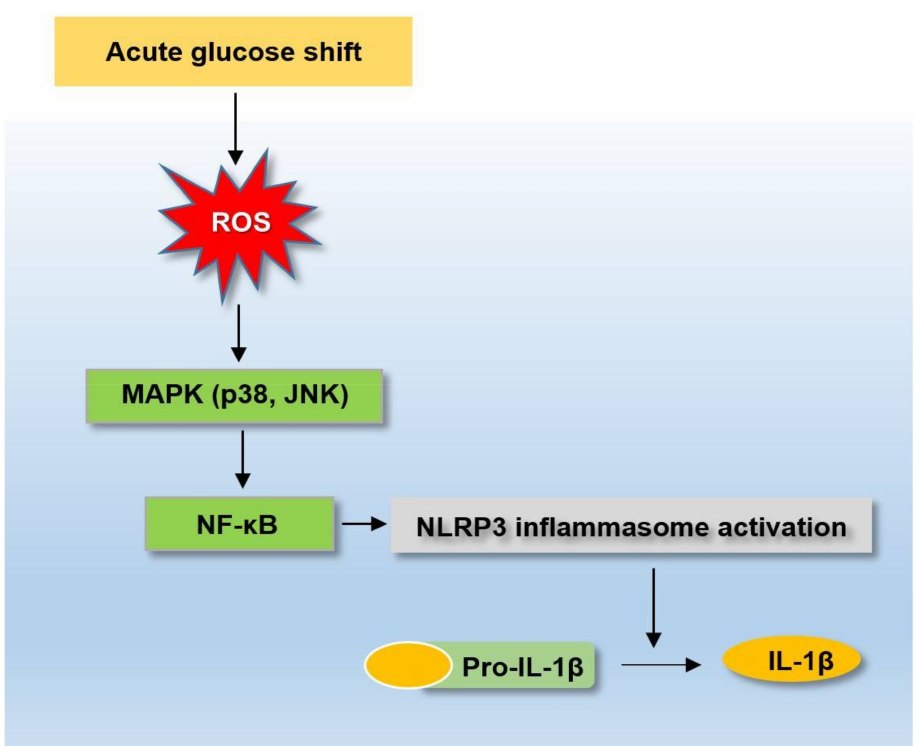
Figure 6. Schematic diagram depicting the acute glucose shift-induced activation of the NLRP3 inflammasome. An acute glucose shift induces the activation of the NLRP3 inflammasome, which is mediated by the activation of the MAPK and NF- κ B signaling pathways through the generation of